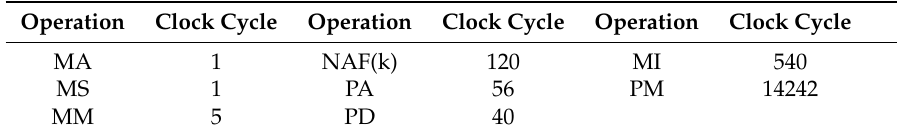
Table 1. The clock cycle of EC operations.